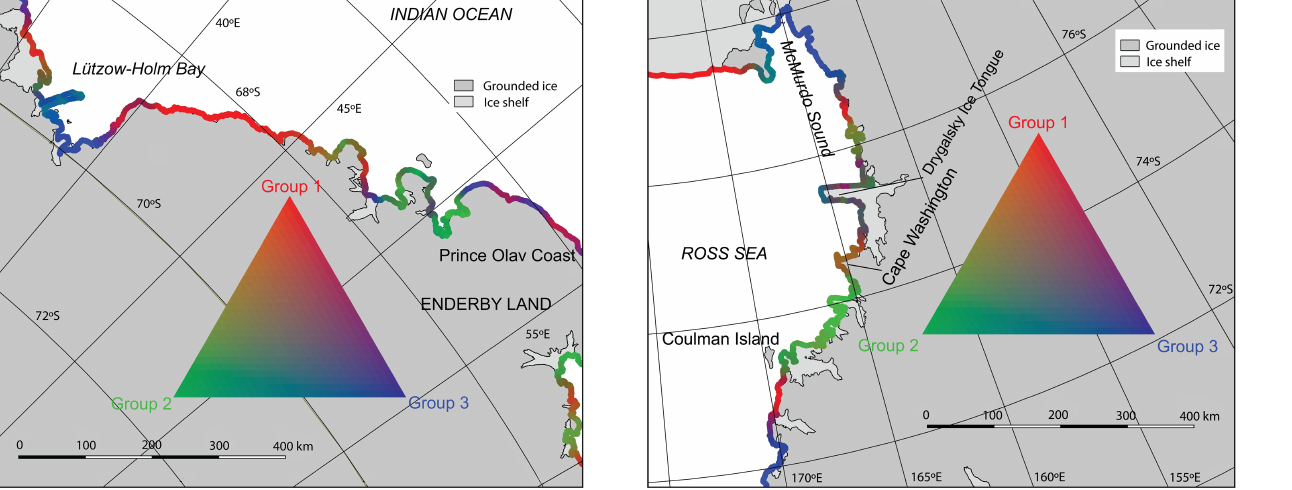
Figure 11. Enlargement of the western Ross Sea coastal area high- lighting the diverse range of coastal classes. The smooth Ross Ice Shelf is predominantly group 1, with group 3 dominating the coastal inflection points at McMurdo Sound and Cape Adare. The remain- der of the coast is largely mixed, except for a region of group 2 from Cape Washington at 74.7 ◦ S to Coulman Island at 73.3 ◦ S. Fast ice forms readily within the protection of McMurdo Sound but with in- crementally lower persistence further north (Fraser et al., 2020). The northern and southern side of the Drygalski Ice Tongue have identi- cal complexity classes but very different glaciology (sometimes fast ice to the south but almost always ice-free or polynya to the north). This highlights the role of embayment aspect, which is independent of